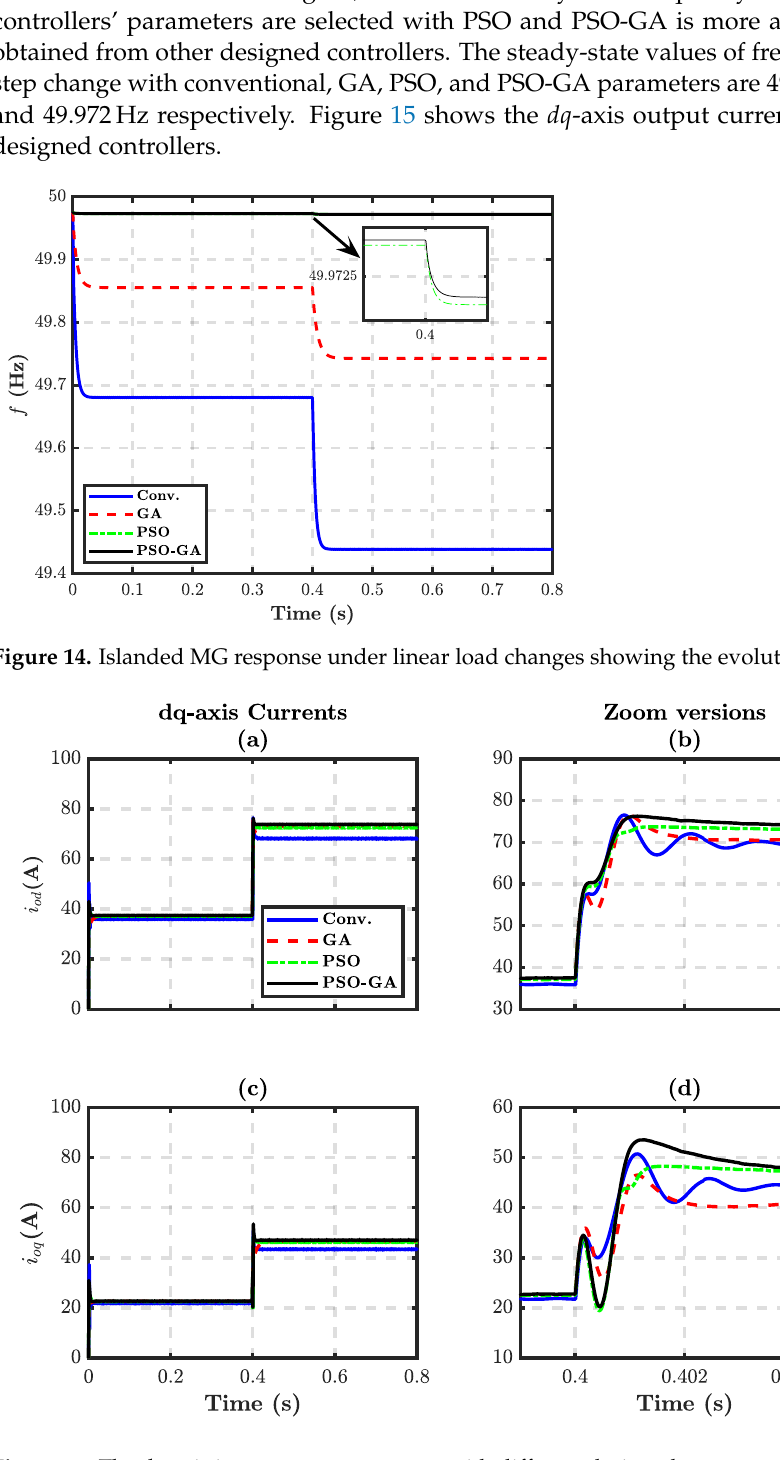
Figure 15. The dq -axis inverter output current with different designed parameters: ( a ) d -axis current; ( b ) d -axis current zoom version; ( c ) q -axis current; ( d ) q -axis current zoom